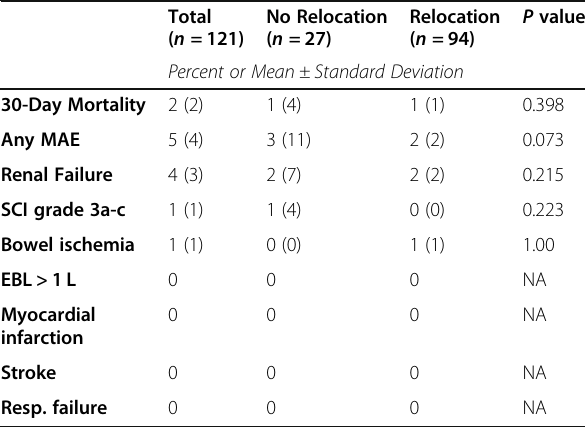
Table 4 Major adverse events (MAE) of 121 patients undergoing fenestrated endovascular aortic repair (FEVAR) using the Zenith Fenestrated AAA Endovascular® with large fenestrations for superior mesenteric artery